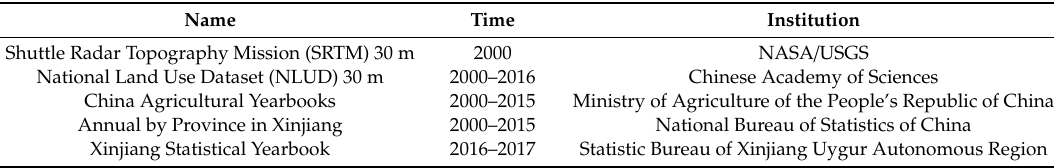
Table 4. The information of the auxiliary